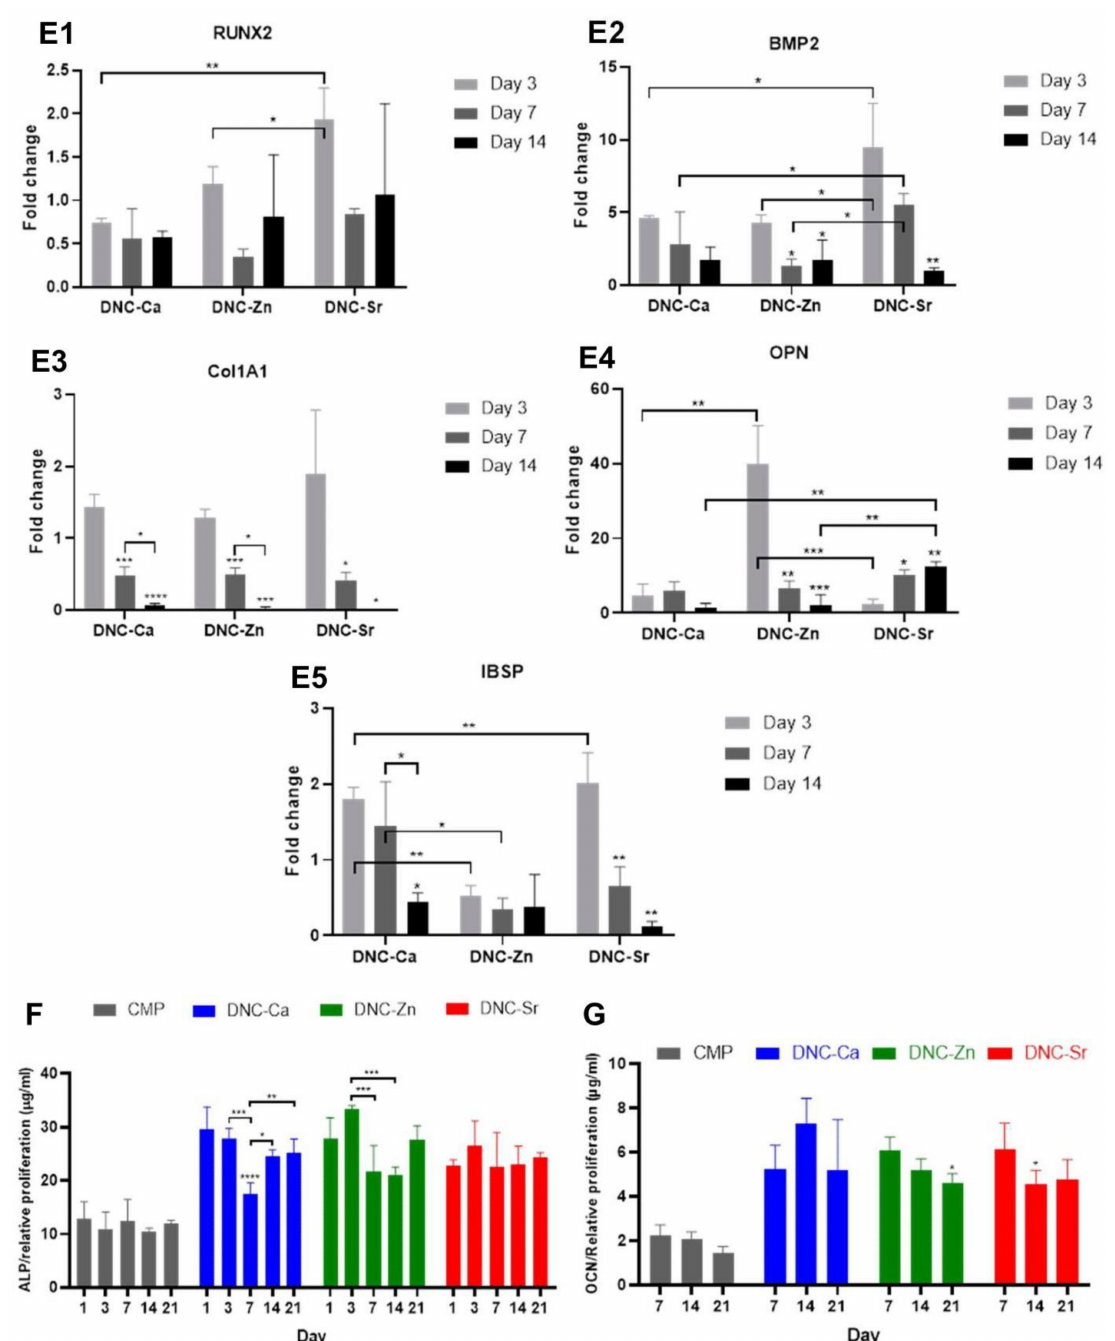
Figure 5. In vitro biological evaluation of dual network composites chelated with Ca 2+ (DNC-Ca), Zn 2+ (DNC-Zn) and Sr 2+ (DNC-Sr): ( A1–A3 ) human osteoblast-like cell (HOS TE85) viability following exposure to scaffold eluants; ( B ) bovine serum albumin (BSA) protein adsorption (mg/g); ( C ) human bone marrow mesenchymal stem cells (hBMSC’s) relative proliferation; ( D ) total protein production/relative proliferation; ( E1 ) runt-related transcription factor 2 (RUNX2) ( E2 ) bone morphogenetic protein-2 (BMP2), ( E3 ) collagen 1 alpha 1 (COL1A1), ( E4 ) osteopontin (OPN) and ( E5 ) bone sialoprotein (IBSP) gene expression; ( F ) alkaline phosphatase (ALP) production/relative proliferation; ( G ) osteocalcin (OCN) production/relative proliferation. Bars represent means and error bars represent SD’s ( n = 4). Statistical significance was verified with one-way ANOVA and post hoc Tukey’s analysis (* p < 0.05, ** p ≤ 0.01, *** p ≤ 0.001, and **** p ≤